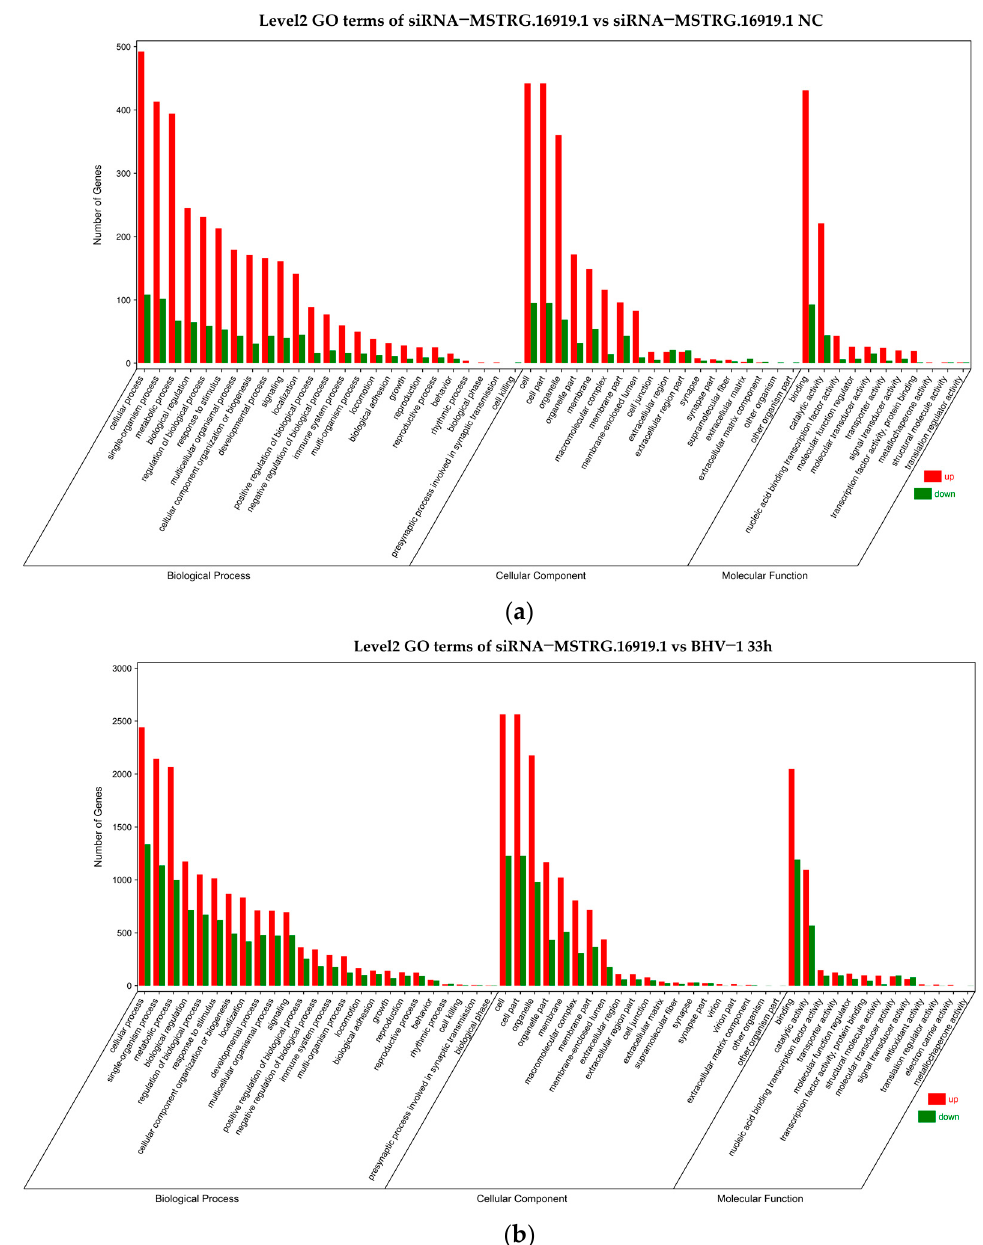
Figure 6. GO enrichment classification histogram. ( a ) Level 2 GO terms of siRNA − MSTRG.16919.1 and siRNA − MSTRG.16919.1 NC ; ( b ) level 2 GO terms of siRNA − MSTRG.16919.1 and BHV − 1 33 h. The abscissa is the second − level GO term, and the ordinate is the number of differential genes in the term. Red indicates upregulation and green indicates downregulation.